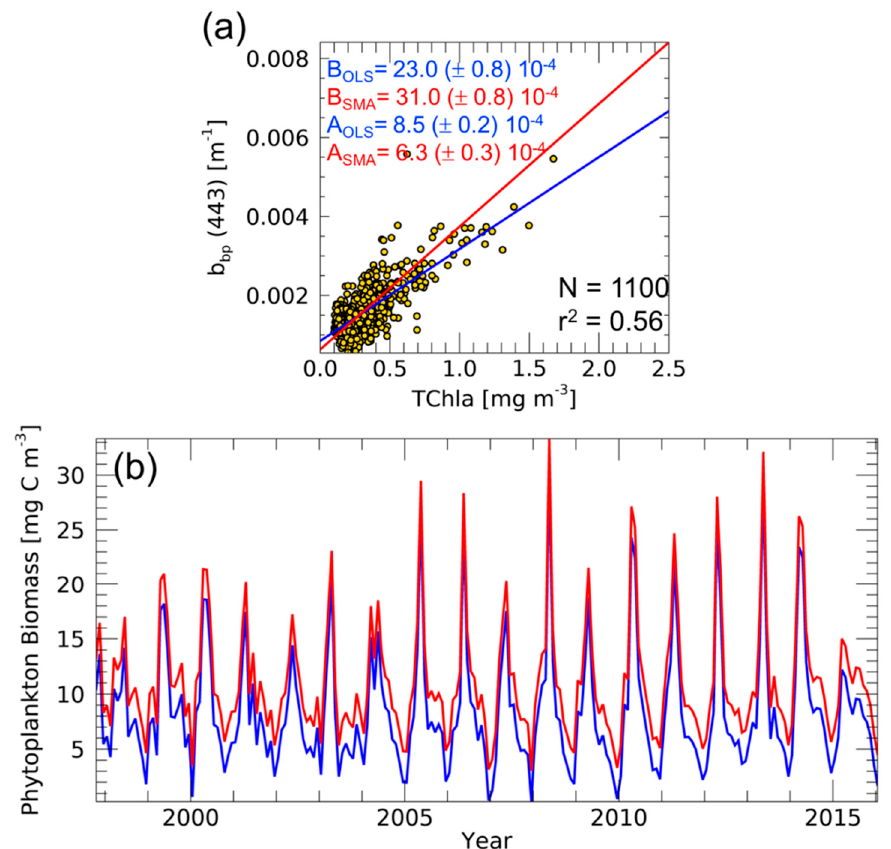
Figure 3. Scatter plot between TChla and b bp from ocean colour data in the northwestern Mediterranean Sea with linear fits (continuous lines) calculated with OLS (blue) and SMA (red) methods ( a ). For both the coefficients, intercepts (A) and slopes (B), the standard errors are also indicated. Time series of C phyto ( b ) based on the b kbp computed by OLS (in blue) and SMA (in red) methods.